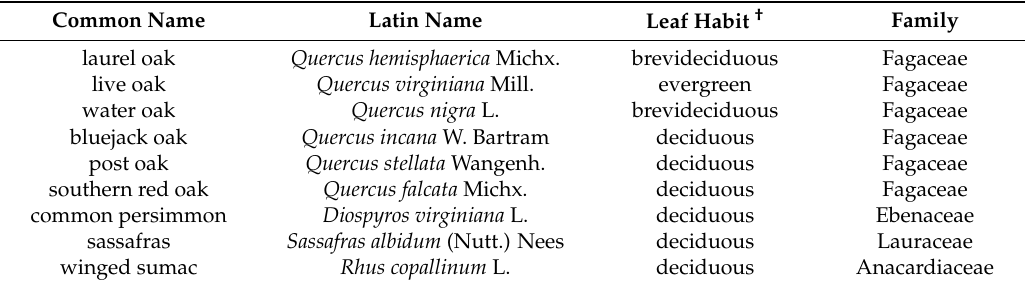
Table 2. Leafing behavior and taxonomic affinity of common hardwood tree species that persist in shrub form in frequently burned longleaf pine woodland in southwest Georgia,